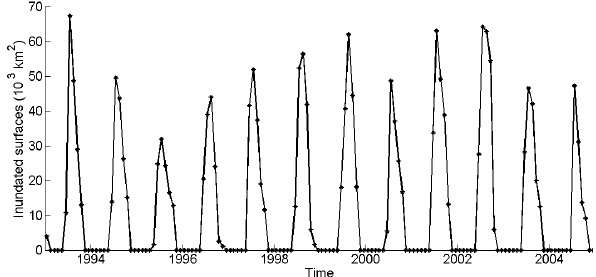
Figure 2. Monthly time variations of the inundated areas (km 2 ) in the Lower Ob’ River Basin 1 Fig. 2. Monthly time variations of the inundated areas (km 2 ) in the from 1993 to 2004. 2 Lower Ob’ River Basin from 1993 to